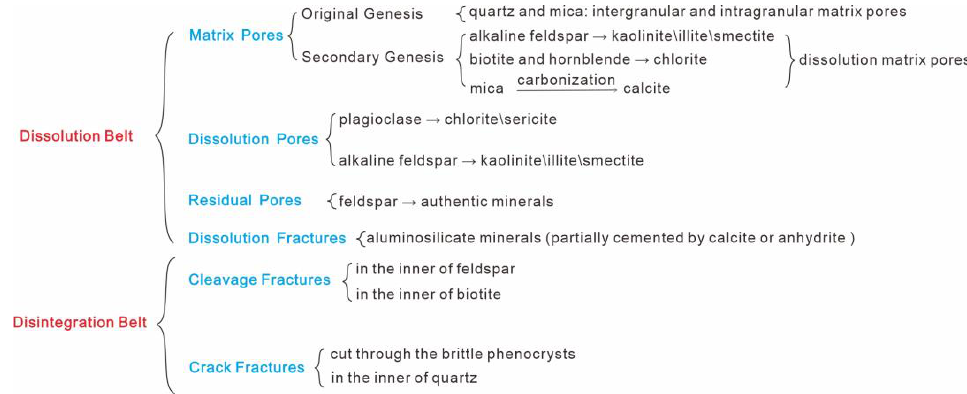
Figure 10. Genesis of reservoirs in distinct weathering crust layers.